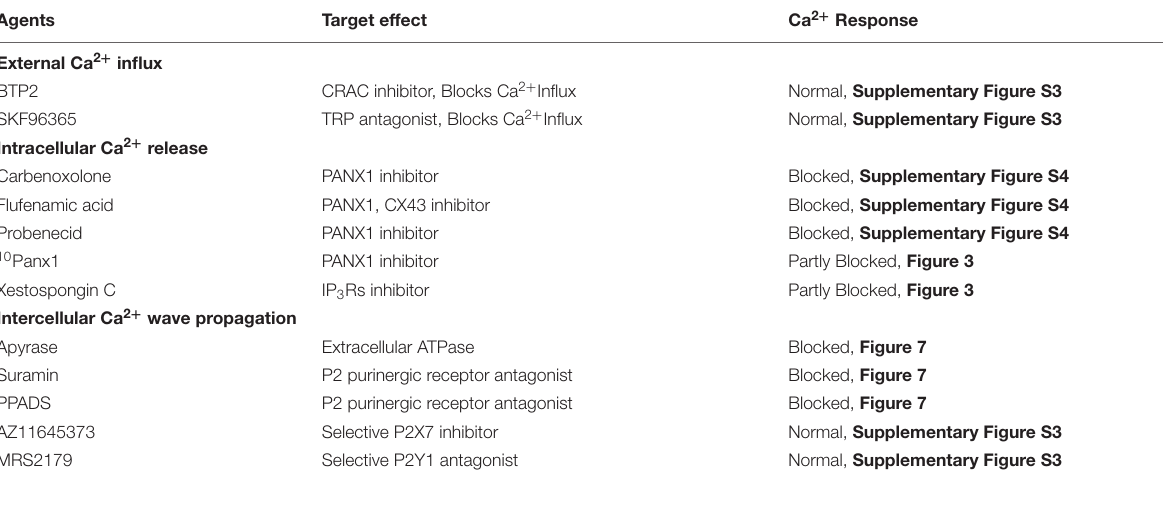
TABLE 1 | Pharmacological effects of agents on FUS-stimulated Ca 2 + dynamics in PC-3